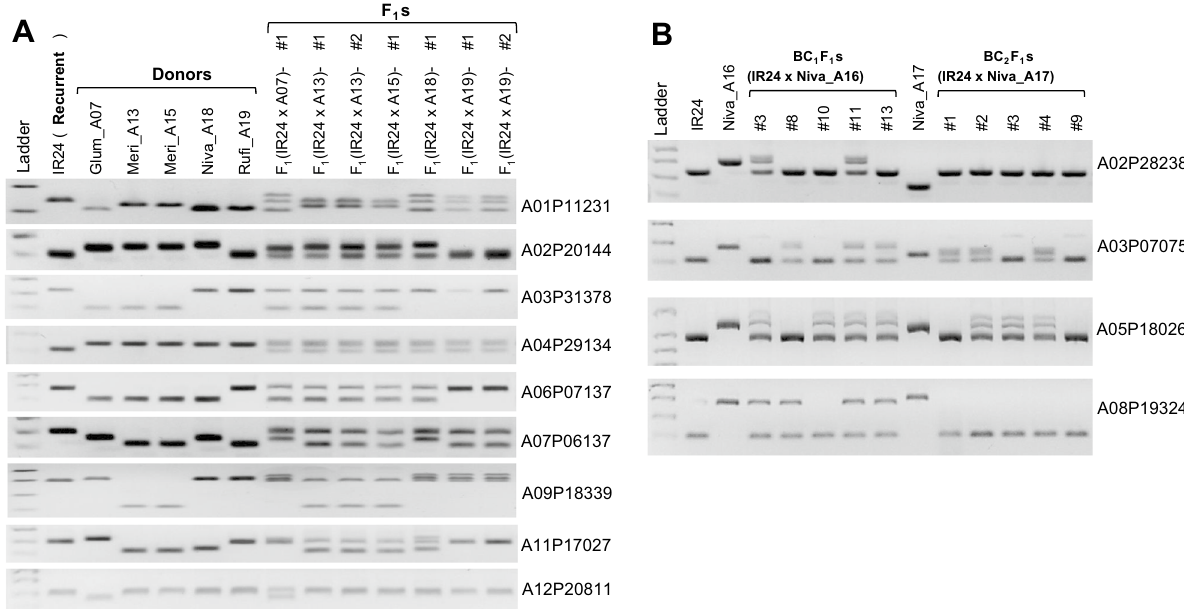
Figure 2. Applications of the newly developed markers in the early generations of hybrids between IR24 and wild species. ( A ) Test of the markers in F 1 plants together with both recurrent (IR24) and donor parents. ( B ) Test of the markers in BC 1 F 1 and BC 2 F 1 plants derived from accessions Niva_A16 and markers between IR24 and 21 accessions is 323.0. The marker number ranges from 187 (IR24 vs Glum_A09) to 391 (IR24 vs Long_A11) (Table 2). Based on these results, we made groups of polymorphic marker sets at the species level for easy selection of potential polymorphic markers based on the species. Briefly, all the polymor- phic markers were collected from three accessions in each species and then the accession-specific polymorphic markers and the common polymorphic markers between two accessions or among three accessions were identi- fied and listed (Supplementary Tables, Table S2: O. barthii , Table S3: O. glaberrima , Table S4: O. glumaepatula , Table S5: O. longistaminata , Table S6: O. meridionalis , Table S7: O. nivara , and Table S8: O. rufipogon ). The avail- able polymorphic markers for each species were calculated (shown by a Venn diagram) and mapped on the rice genome (Fig. 3B–H). The number of markers ranges from 338 (IR24 vs O. rufipogon ) to 416 (IR24 vs O. longis- taminata ). These markers will be useful for genetic analysis and breeding purposes between indica cultivars and other AA-genome species. We also surveyed the polymorphic markers between IR24 and three accessions of japonica varieties (Supplementary Table S9) and we obtained 272 markers without redundancy (Fig. 3I). By the same analysis, the polymorphic markers between a japonica rice variety (Nipponbare) and 21 acces- sions of AA-genome species were analyzed. The average number of polymorphic markers between Nipponbare and 21 accessions is 187.4 and it ranges from 126 (Nipponbare vs Niva_A16) to 243 (Nipponbare vs Long_A11) (Table 2). The polymorphic markers between Nipponbare and the other seven species were selected respec- tively and listed in Supplementary Tables S10 to S16. Distributions of the markers were presented on the rice genome maps (Supplementary Fig. S2A–G). A survey of the polymorphic markers between Nipponbare and three japonica varieties revealed that only 64 markers out of 475 showed polymorphism (Supplementary Table S17 and Supplementary Fig. S2H). This result indicates that a high genome similarity exists among the japonica varieties although the three accessions originated from far distances (Table 1).